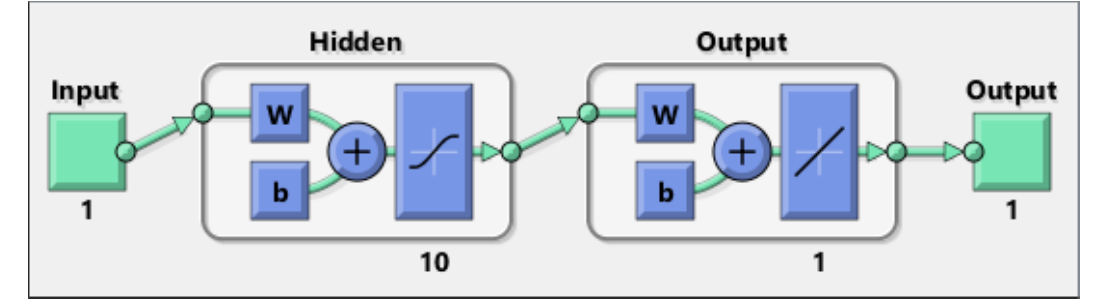
Figure 8. Example of single hidden layer perceptron.